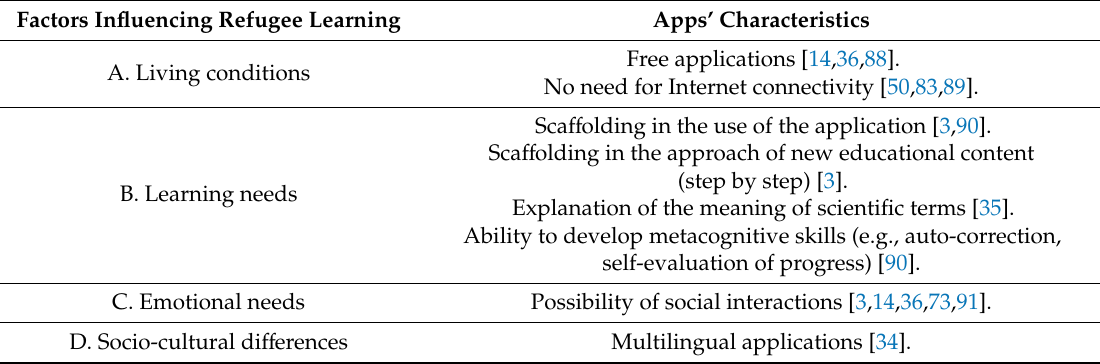
Table 2. Characteristics of mobile learning applications proposed in the